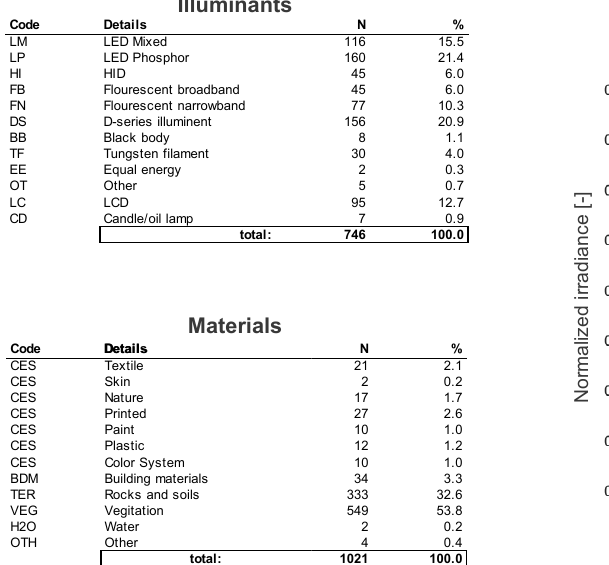
Table 1. A high-level description of the contents of our spectral libraries for the illuminants ( left ) and material reflectances ( right ). Of the 746 illuminant spectra 146 are theoretical and 600 are real. NB: CES refers to ’color evaluation sample’. Reflectance spectra in the CES set are uniformly distributed across the NCS color gamut. The complete library with verbose descriptions of the spectra can be found in the supplemental material.